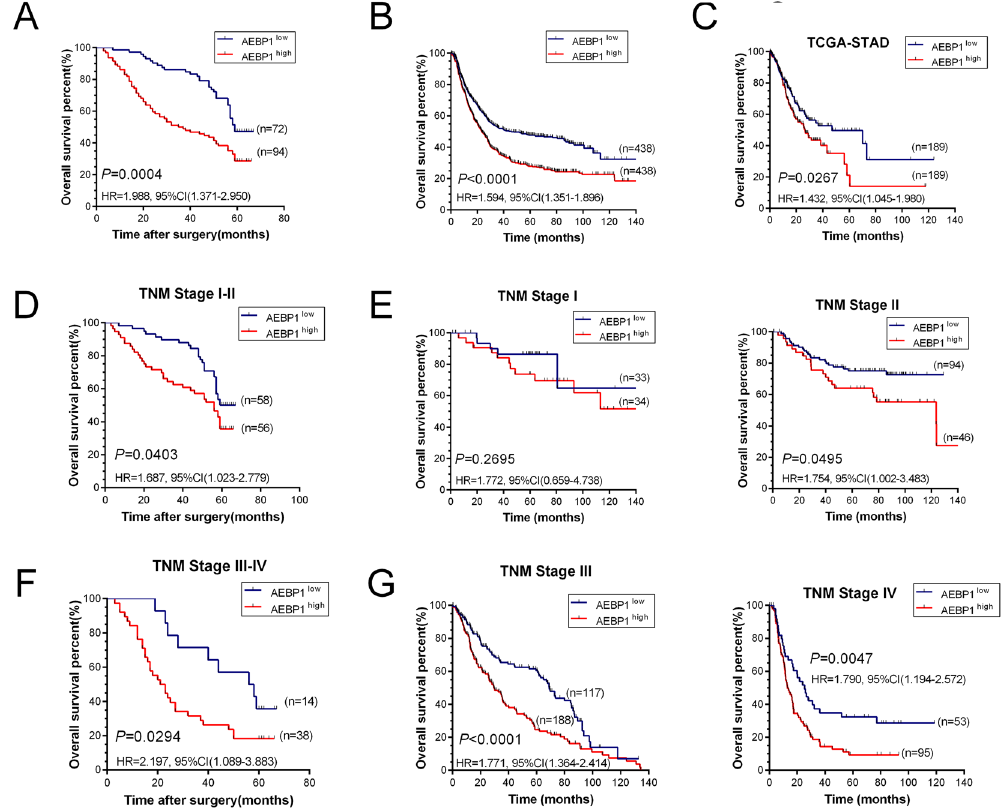
Figure 3. Elevated expression of AEBP1 is associated with poor overall survival (OS) rate in patients with both early-stage (TNM I and II) and late-stage (TNM III and IV) gastric cancer. ( A ) Kaplan-Meier analysis of 166 patients with gastric cancer indicating high AEBP1 expression is associated with poor overall survival (P = 0.0004). ( B ) Kaplan-Meier analysis of 876 patients with gastric cancer from NCBI GEO database revealing AEBP1 high patients had a significantly lower overall survival rate than those with AEBP1 low tumors (P < 0.0001). ( C ) Kaplan-Meier analysis of 378 patients with gastric cancer from TCGA-STAD database indicating AEBP1 high patients had a lower overall survival rate than those with AEBP1 low tumors (P = 0.0267). ( D ) Kaplan-Meier analyses of patients with TNM I and II stage gastric cancer from our cohort showing high expression of AEBP1 is correlated with a lower overall survival rate (P = 0.0403). ( E ) Kaplan-Meier analyses from the NCBI GEO database in patients with TNM I (P = 0.2695) and TNM II (P = 0.0495) stage gastric cancer. ( F ) Kaplan-Meier estimation of patients with TNM III and IV stage gastric cancer from our cohort showing high expression of AEBP1 is correlated with a lower overall survival rate (P = 0.0294). ( G ) Kaplan-Meier analyses from NCBI GEO database in patients with TNM III (P < 0.0001) and TNM IV (P = 0.0047) stage gastric cancer.